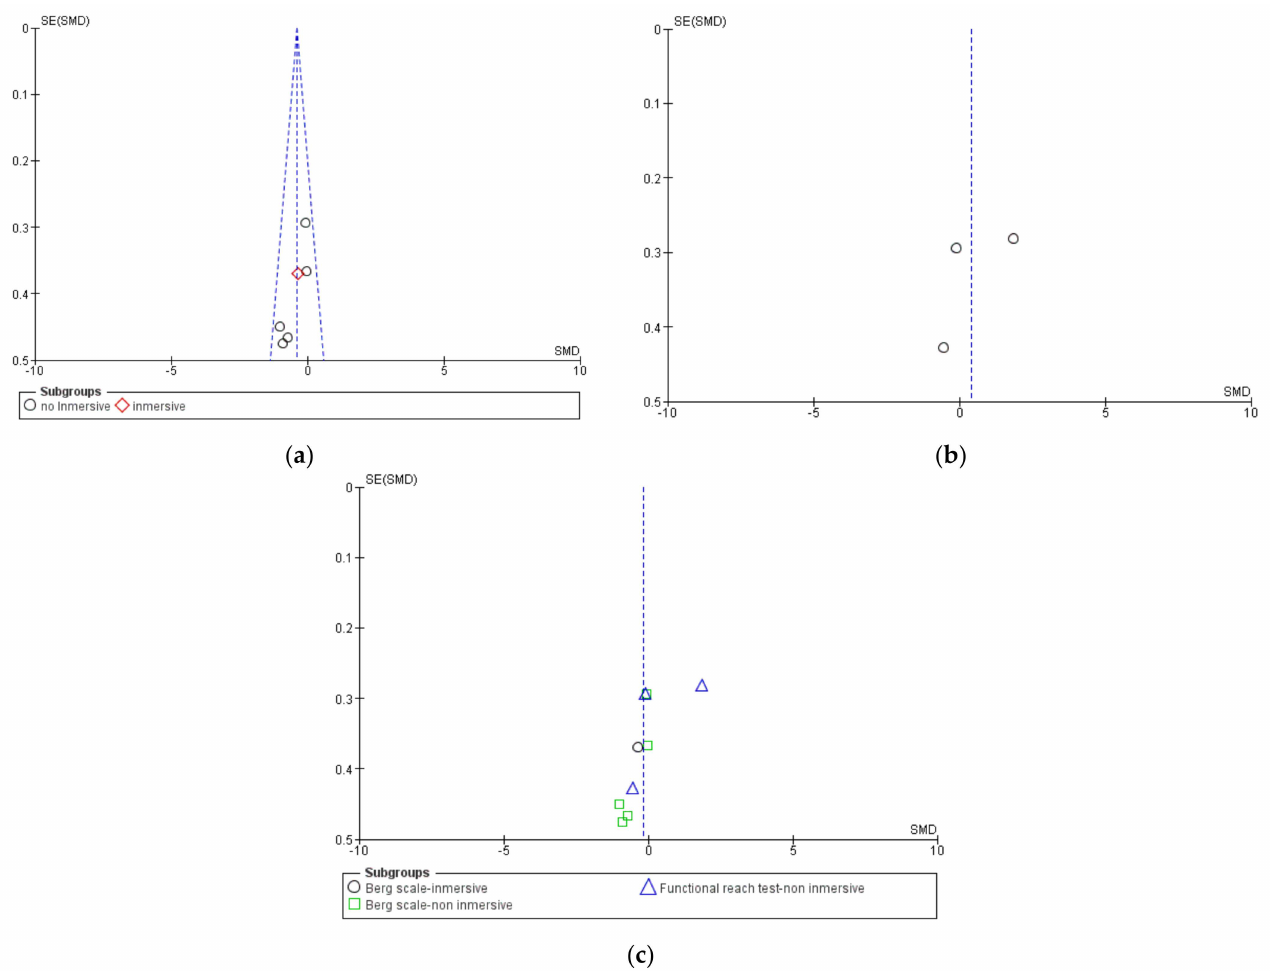
Figure 11. Funnel plots for static balance. ( a ) Static balance measured using Berg scale, ( b ) static balance measured using functional reach test, and ( c ) global static